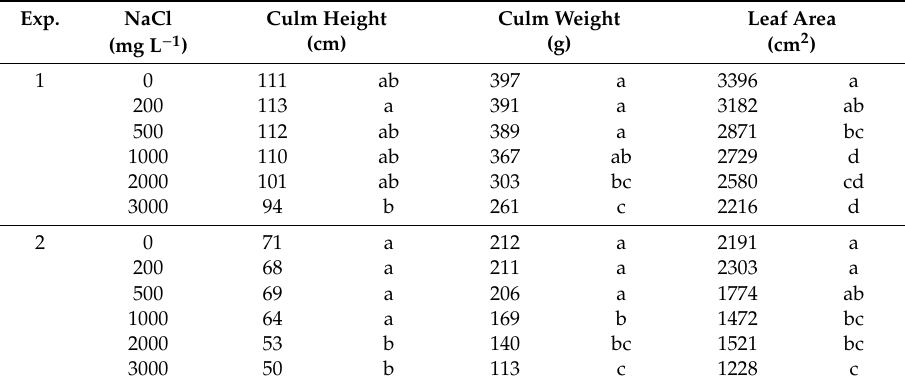
Table 2. E ff ects of NaCl levels in irrigation water on growth